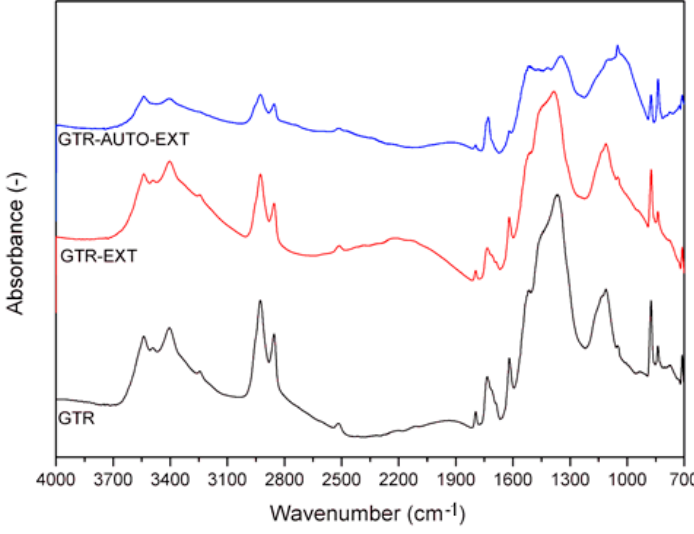
Figure 7. FTIR spectra of GTR, GTR-EXT, and GTR-AUTO-EXT samples.